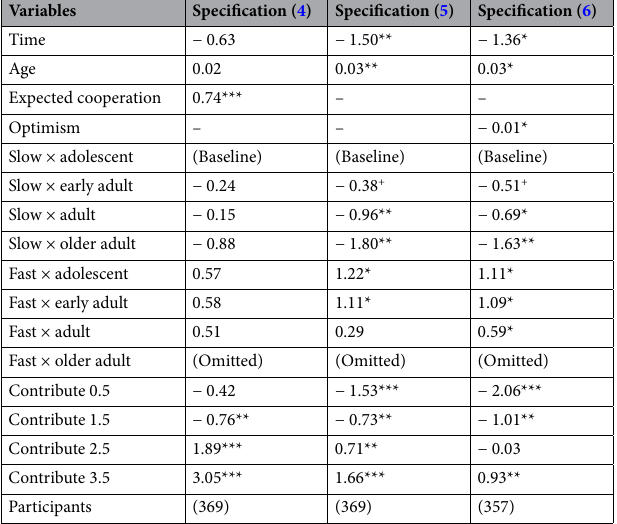
Table 3. Ordered probit estimates of specifications (4), (5) and (6). + p < 0.15 (marginally significant), *p < 0.05,